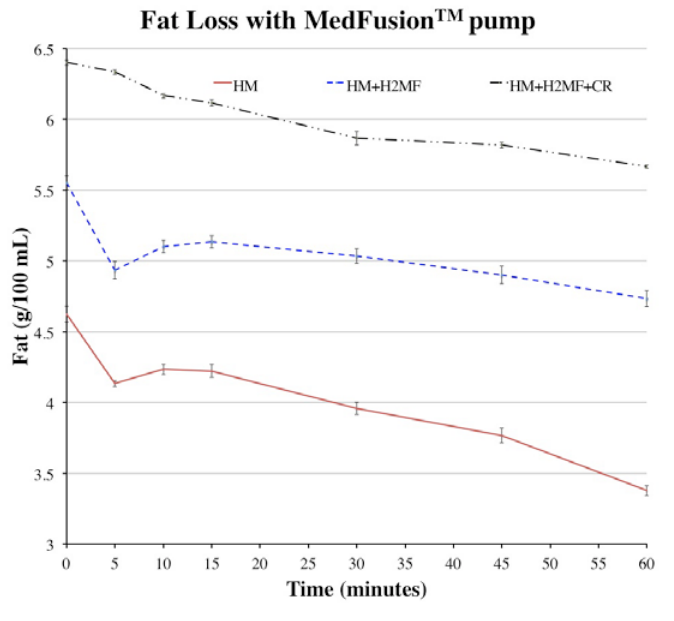
Figure 2. Fat values over one-hour feeds with HM, HM + H 2 MF, and HM + H 2 MF + cream with MedFusion™ syringe pump. HM: human milk; H 2 MF: HM supplemented with donor HM-derived fortifier Prolacta + H 2 MF™; Cream: HM supplemented with H 2 MF and